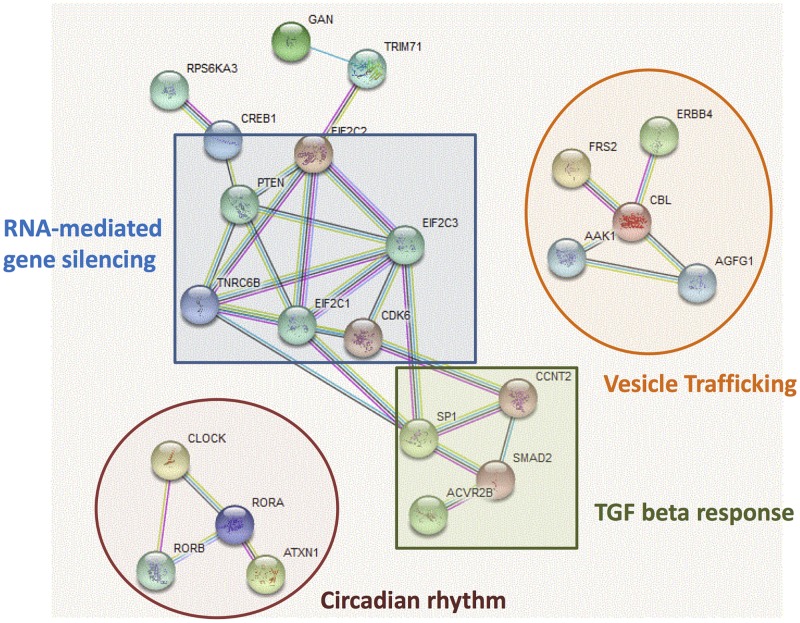
Protein-protein interactions between the 100 most targeted genes by the 299 miRNAs expressed in left atria from patients suffering from valvular heart disease.Predicted protein-protein interactions are from STRING. The interactions include direct (physical) and indirect (functional) associations either from computational predictions or from knowledge transfer between organisms or from interactions aggregated from other (primary) databases. The list of genes is given in S2 Table.